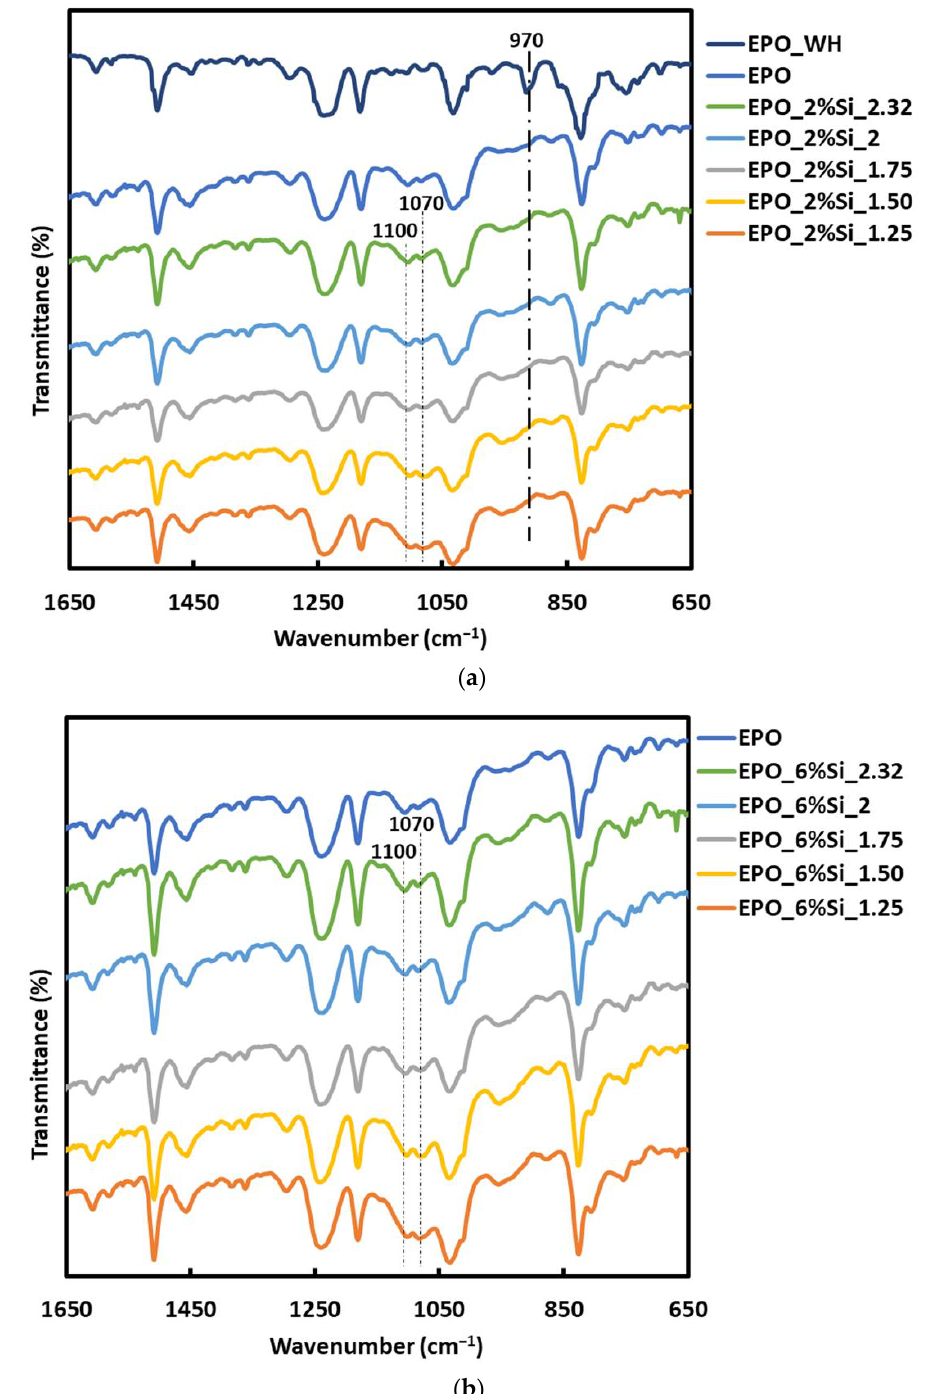
Figure 1. FTIR spectra of EPO_WH, EPO, and of the nanocomposites containing ( a ) 2 wt.% of silica and ( b ) 6 wt.% of silica, at different TEOS/APTS ratios.